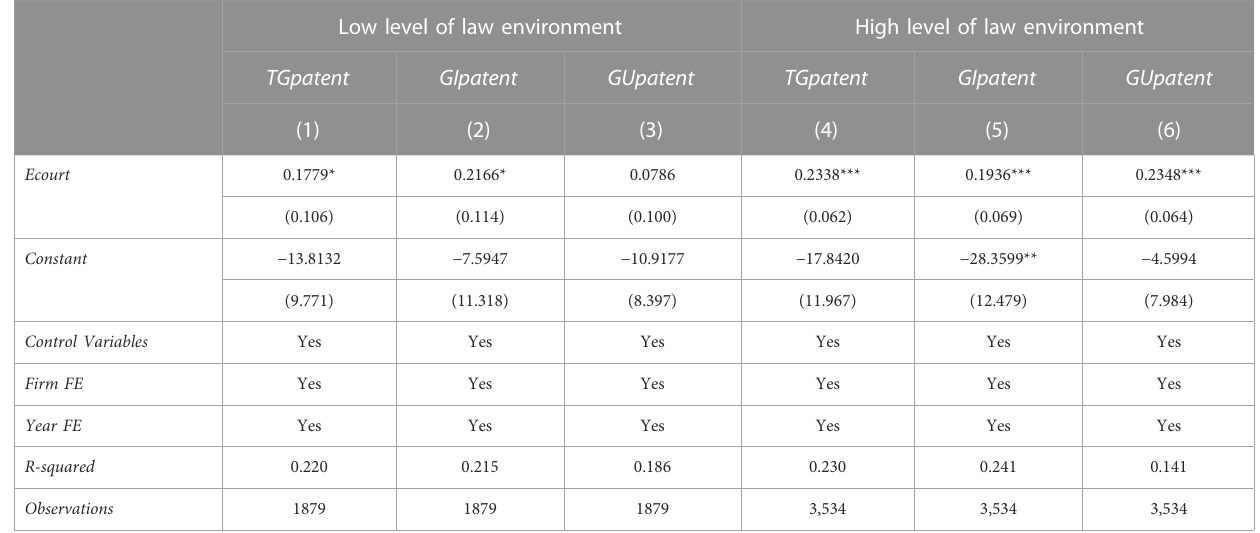
TABLE 7 The level of local law